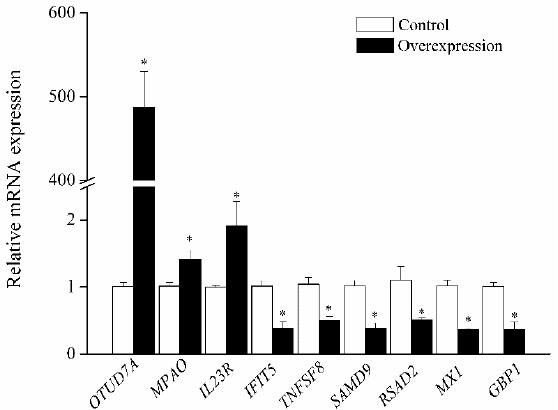
Figure 2. Validation of differentially expressed genes of the control and ovarian tumor deubiquitinase 7A ( OTUD7A ) overexpression groups in goose hepatocytes; * p < 0.05. Data are shown as the mean ± SEM of six replicates for each treatment. MPAO : membrane primary amine oxidase; MX1 : interferon-induced GTP-binding protein Mx1; IL23R : interleukin-23 receptor; IFIT5 : interferon- induced protein with tetratricopeptide repeats 5; TNFSF8 : tumor necrosis factor ligand superfami- ly member 8; RSAD2 : radical S -adenosyl methionine domain-containing protein 2; GBP1 : interfer- on-induced guanylate binding protein 1-like; SAMD9 : sterile alpha motif domain-containing pro- tein 9. Table 2. The upregulated genes in hepatocytes transfected with pcDNA3.1(+) containing goose OTU deubiquitinase 7A CDS and an empty vector.